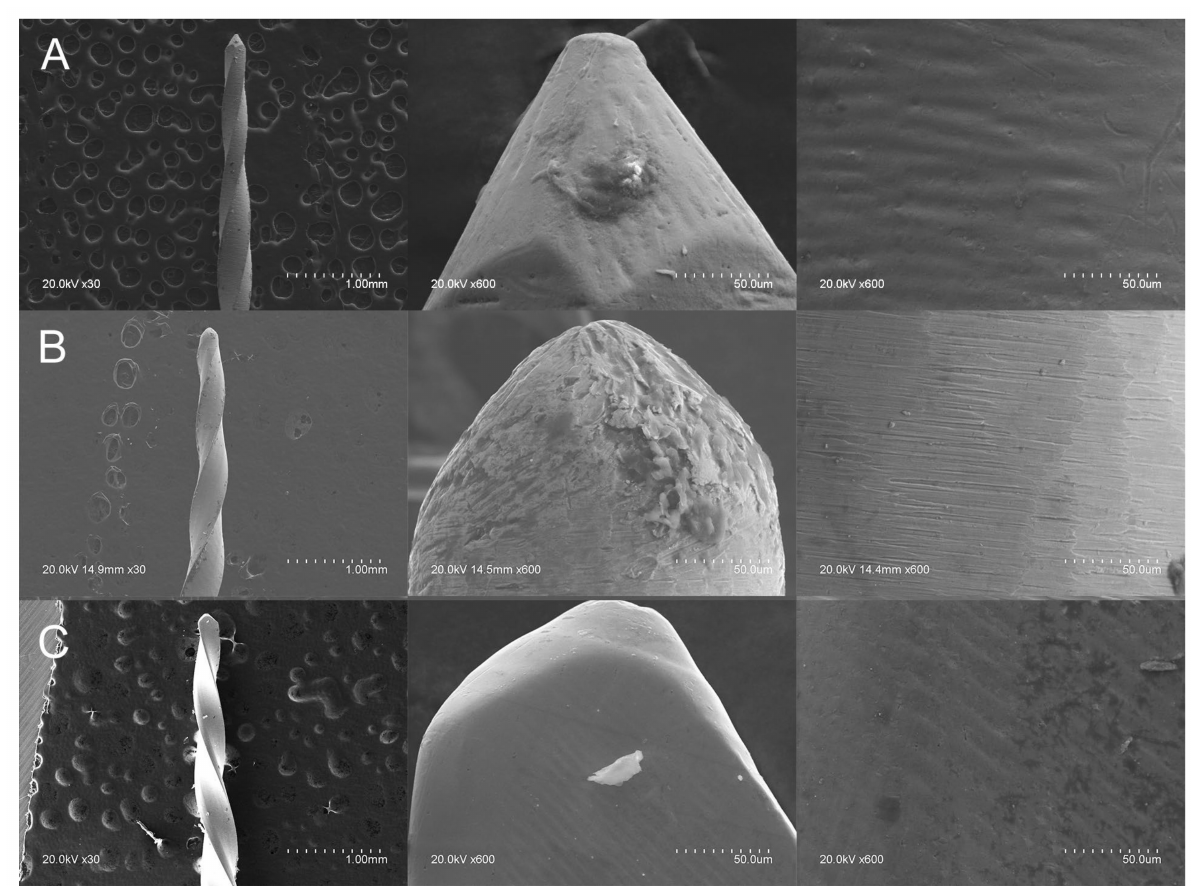
Figure 3. SEM analysis (at 30 × and 600 × ) of: ( A ) EDG NiTi alloy endodontic rotary file, ( B ) PMP heat- treated NiTi alloy endodontic rotary file, and ( C ) ST heat-treated NiTi alloy endodontic reciprocating file. EDX micro-analysis of EDG, PMP, and ST NiTi alloy endodontic files was carried out at 15 and 20 kV. However, the 20 kV acceleration voltage results were more determinant than those at 15 kV. In summary, the EDG, PMP, and ST NiTi alloy endodontic files differed in atomic weight percentages, although the elements present in the chemical composition were similar (Figure 4 and Table 2).